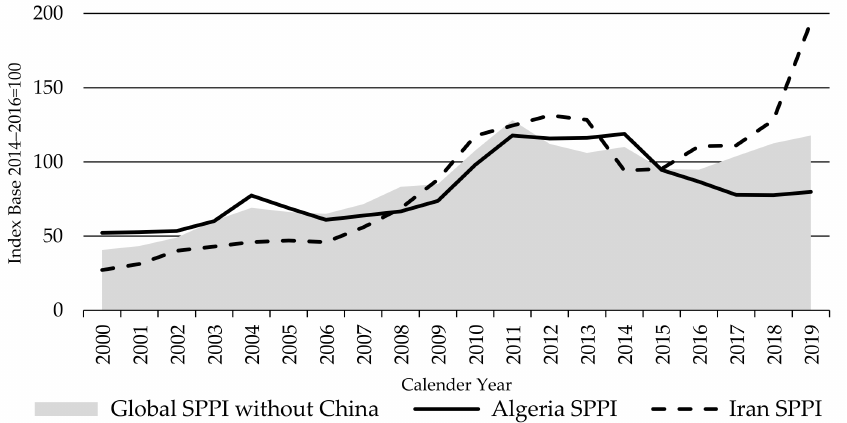
Figure 14. The Global Sheep Meat Producer Price Index SPPI (without China) in comparison with Algeria and Iran Sheep Meat Producer Price Indices SPPIs, source: own illustration.